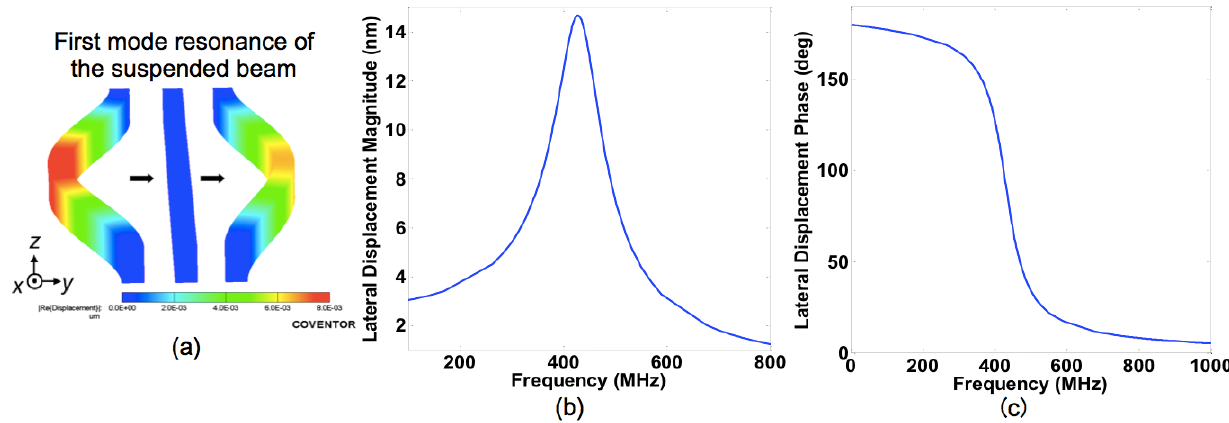
Figure 2. ( a ) The first resonance mode of the suspended beam. ( b ) The magnitude and ( c ) phase of in-plane displacement of the suspended beam versus frequency in the presence of a sinusoidal pressure load.